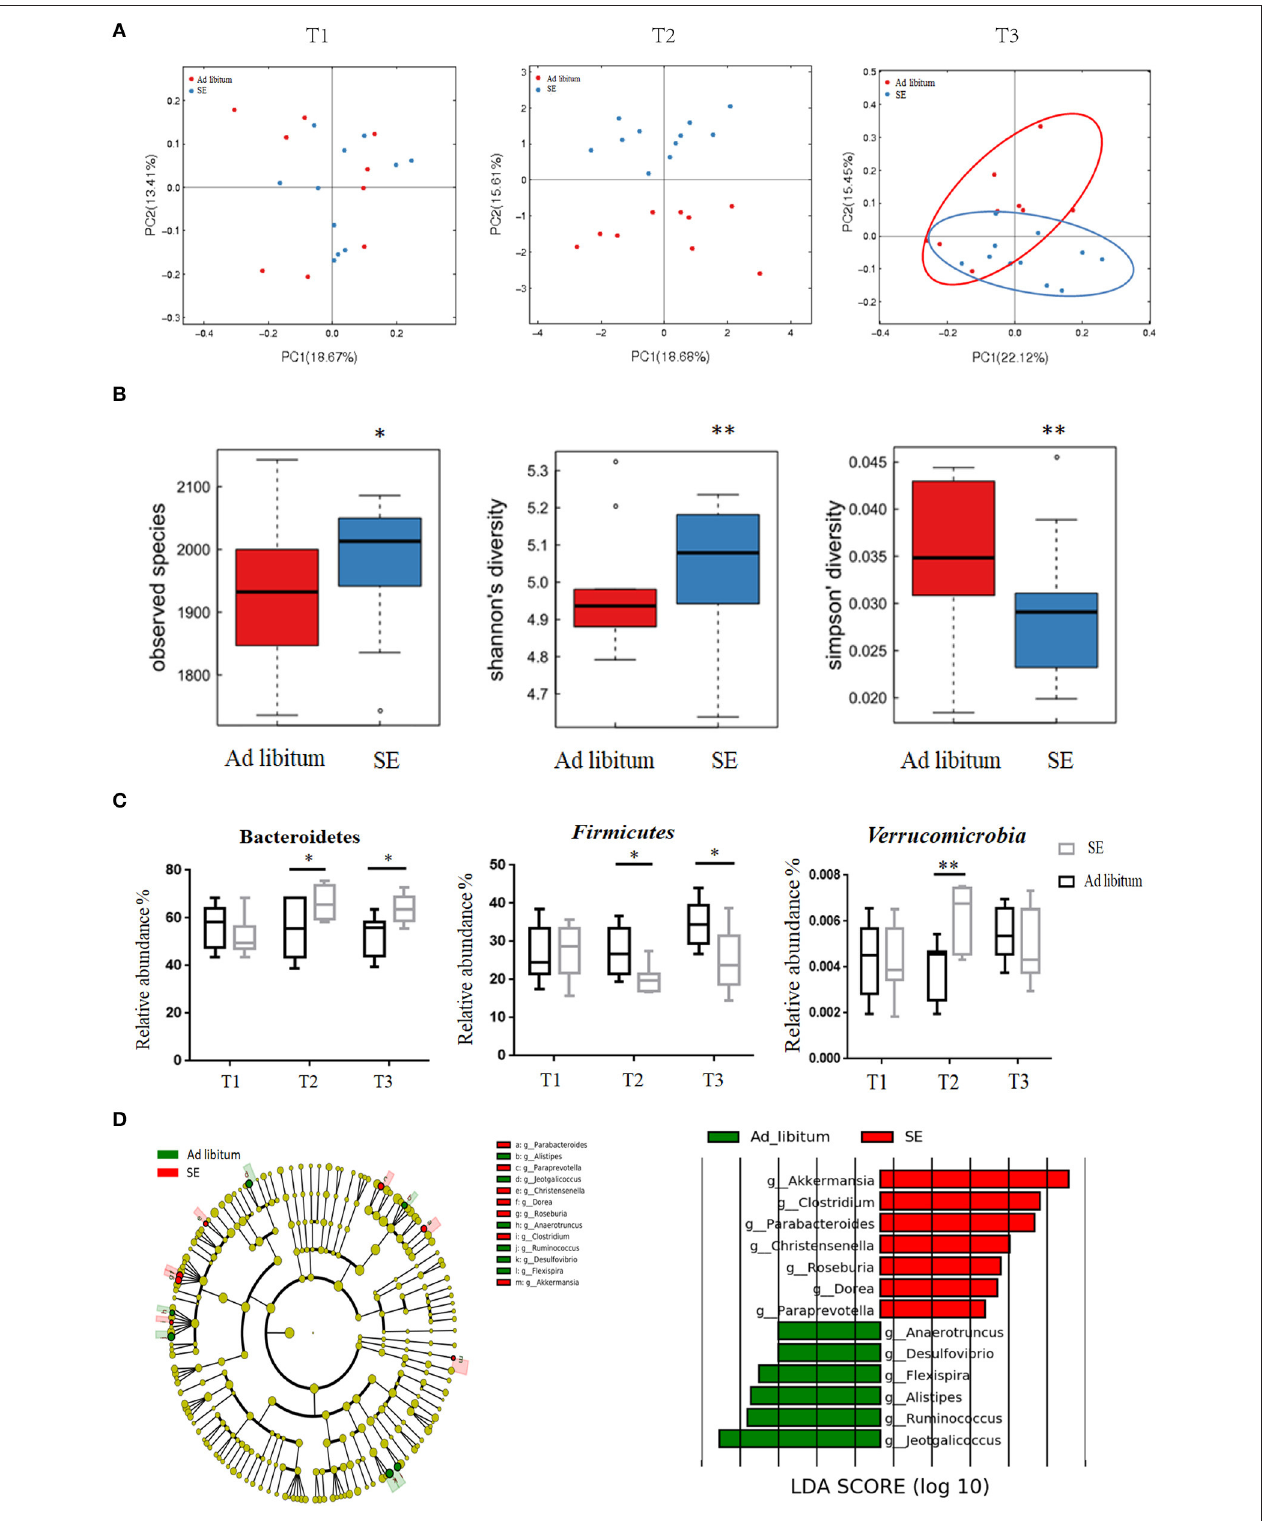
FIGURE 4 | Responses of the diversity, richness, and structure of the gut microbiota on strength exercise in mice. Fecal samples were collected from the SE and ad libitum groups at T1 (baseline, n = 11 in the SE group, n = 9 in the ad libitum group), T2 (after 4 weeks on SE training, prior to EAE immunization, n = 11 in SE, n = 9 in ad libitum ), and T3 (EAE time, n = 11 in SE, n = 9 in ad libitum ). (A) Principal coordinate analysis of Bray–Curtis dissimilarity demonstrated the microbiome similarity of SE and ad libitum groups at T1, T2, and T3 time points. At T1 time point, fecal samples from two groups indicate similar microbiome ( p > 0.05, Adonis test). At